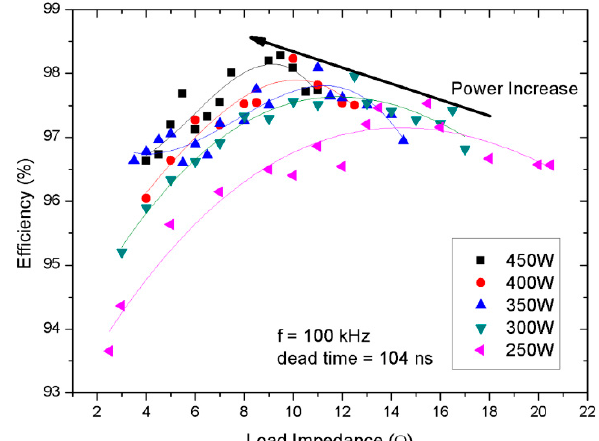
Figure 10. Smart converter efficiency vs. various load impedance and input power from 250 W to 450 W, in steps of 50 W.